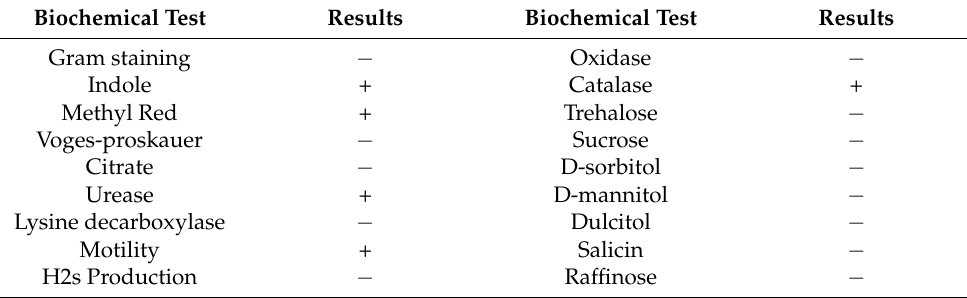
Figure 1. Inflamed and swollen Hirudo medicinalis samples. Table 1. The result of Biochemical tests of Morganella morganii .